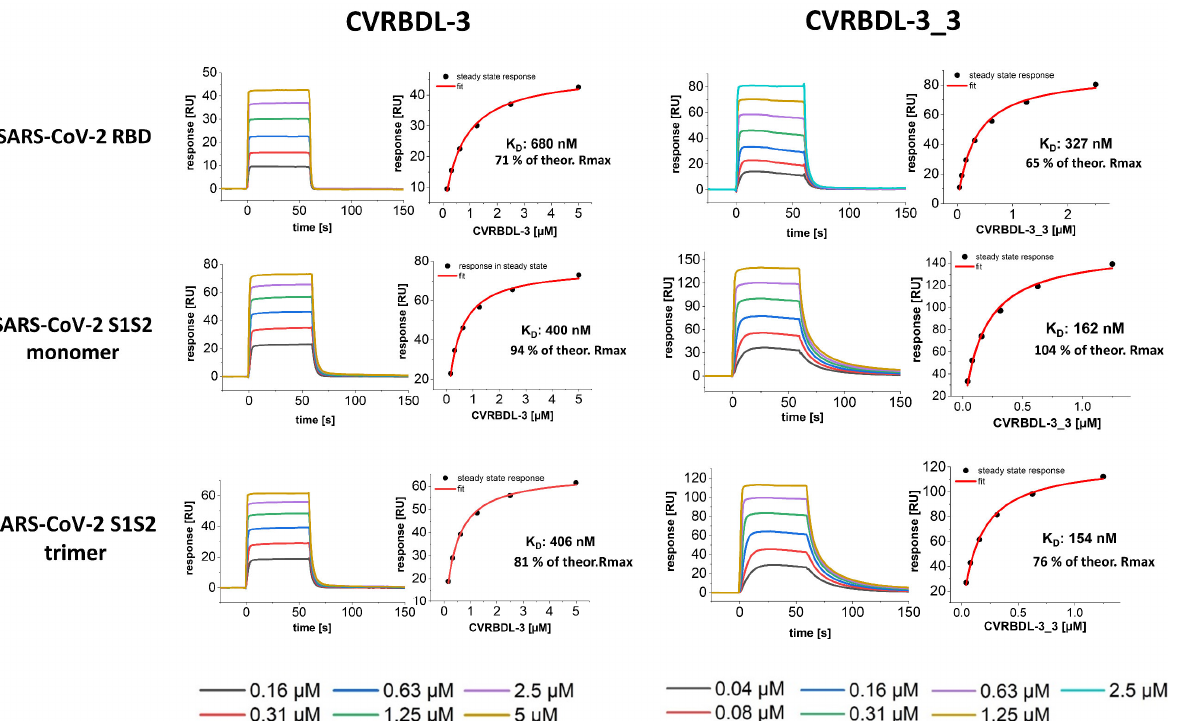
Figure 8. SPR affinity measurement of CVRBDL-3 and CVRBDL-3_3 on the SARS-CoV-2 RBD, S1S2 monomer and trimeric spike constructs. The spike constructs were immobilized on a polycarboxylate matrix by coupling via primary amino groups with sulfo-NHS ester at pH 5.5 (200 HCM, Xantec, GE). Measurements were performed in 10 mM HEPES (pH 7.4), 150 mM NaCl, 3 mM EDTA, 0.005% Tween-20 solution in a T200 device (Cytiva, USA). Six concentrations of each compound were injected for 60 s with a 1:1 serial dilution, with5 µ M being the highest concentration for CVRBDL-3 and 2.5 µ M for CVRBDL-3_3. KD evaluation was performed using Biacore T200 data evaluation software v. 3.2 with an offset of zero. The theoretical Rmax was calculated based on the molecular weight ratio of the interactants and the immobilization level after